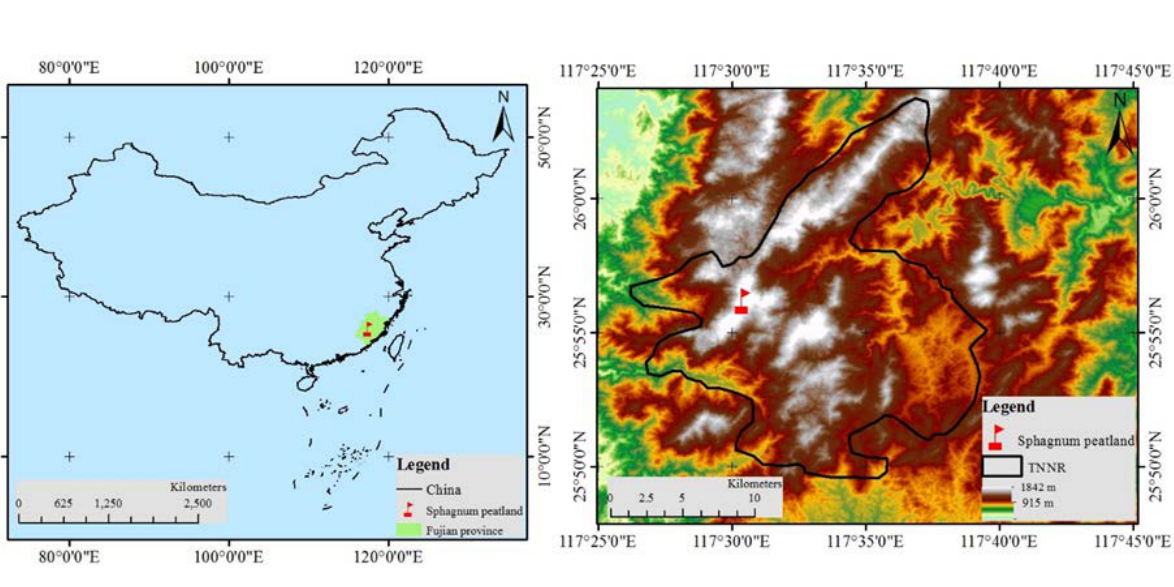
Figure2. Maps showing the location of the study site in Fujian Province, China (left); and within the Tianbaoyan National Nature Reserve (TNNR), superposed on ASTER GDEM base map (right).